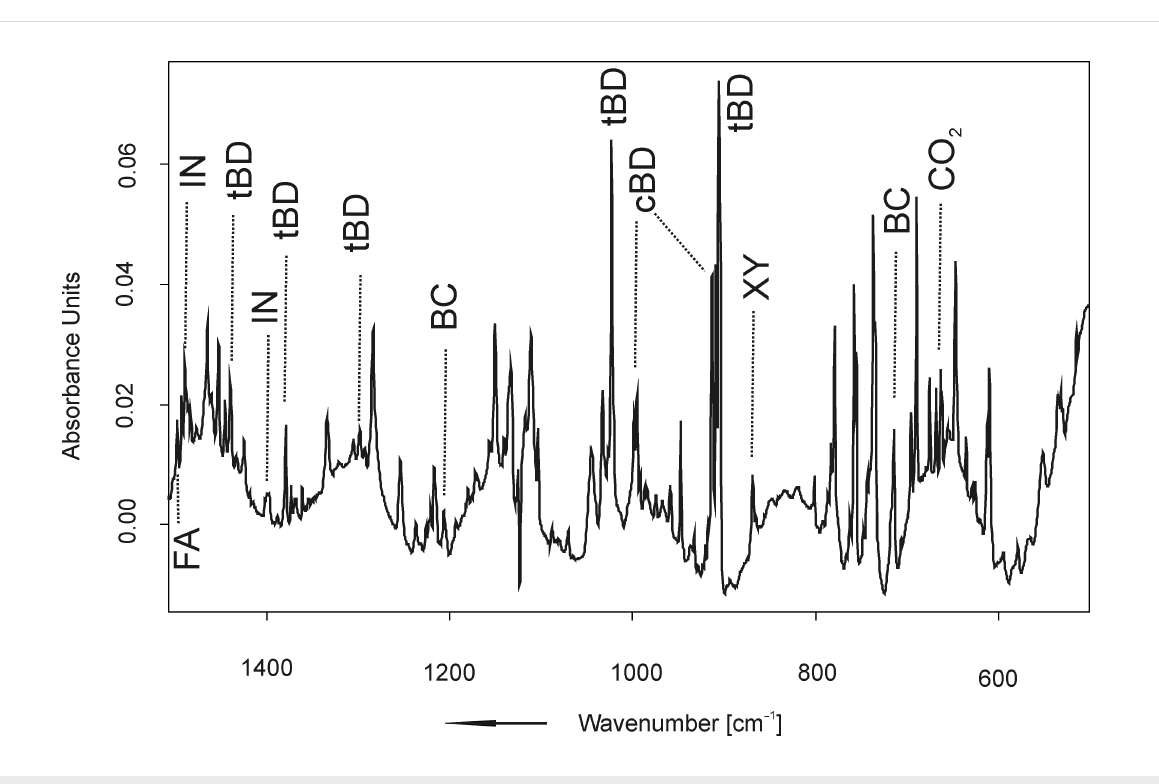
Figure 6: Infrared spectrum obtained upon FVP of 3 at T = 1043 K and trapping the pyrolysate in solid argon at T = 10